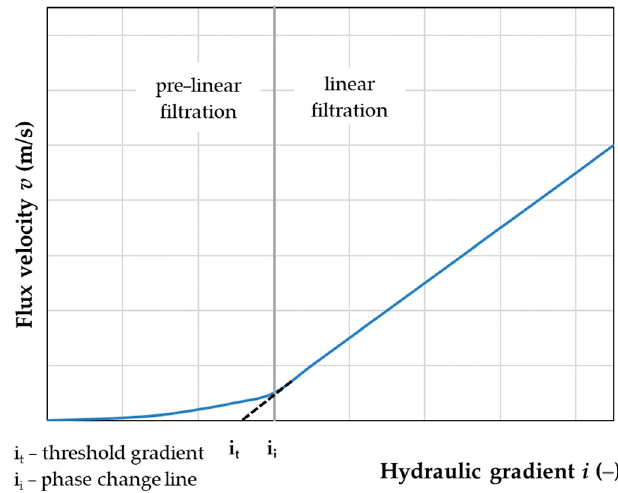
Figure 3. Pre-linear and linear filtration process.